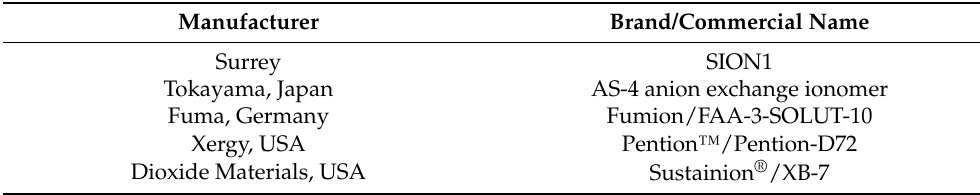
Table 3. Commercially available ionomers for electrode